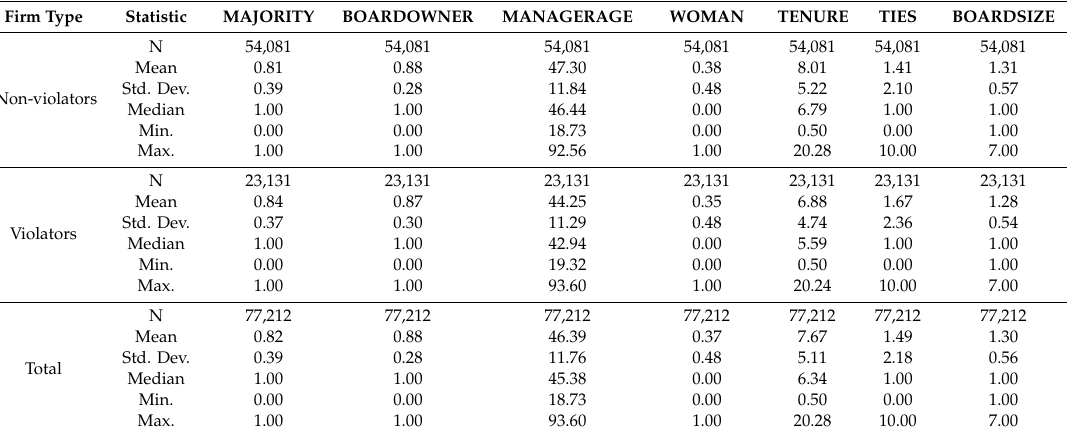
Table 2. Descriptive statistics of corporate governance